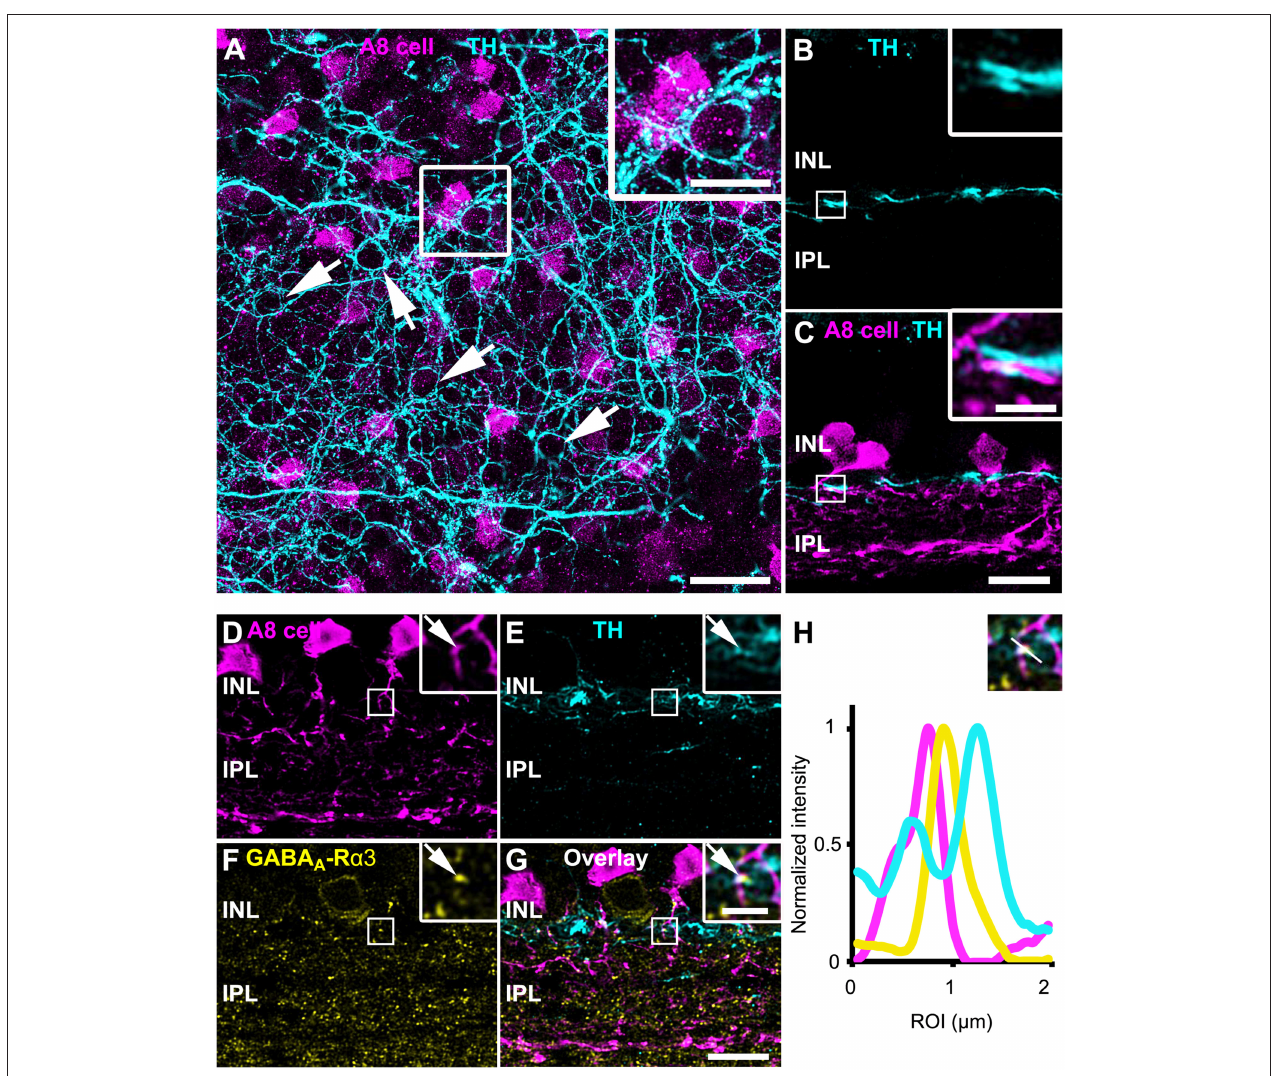
FIGURE 6 | A8 cells presumably receive GABAergic input from tyrosine hydroxylase (TH)-positive cells in the OFF IPL. (A) Maximum projection of an Ier5-GFP whole-mount retina, labeled for TH (cyan). The inset shows the magnified view of the area marked in (A) . Arrows point to perisomatic TH-positive rings, surrounding putative AII cells ( Debertin et al., 2015) but not A8 cells (magenta). (B,C) Same staining as in (A) in a single scan of a vertical slice. Please note the prominent co-fasciculation of TH- and GFP-positive dendrites of dopaminergic and A8 amacrine cells, respectively. (D–G) Maximum projection of GFP-labeled A8 cells (D) , TH-stained ier5-GFP retina (E) , GABA A -R α 3 staining (F) and their overlay (G) . The upper inset shows the magnified view. Arrows point to the colocalization (G) of the three channels (D–F) . (H) Intensity profile of the colocalized area, indicating GABAergic input from dopaminergic amacrine cells to the glycinergic A8 cell. The upper inset shows the single scan of the magnified area shown in the inset of (G) . Scale bar: (A) , 20 µ m; inset: 10 µ m; (B–G) , 10 µ m; inset, 2.5 µ